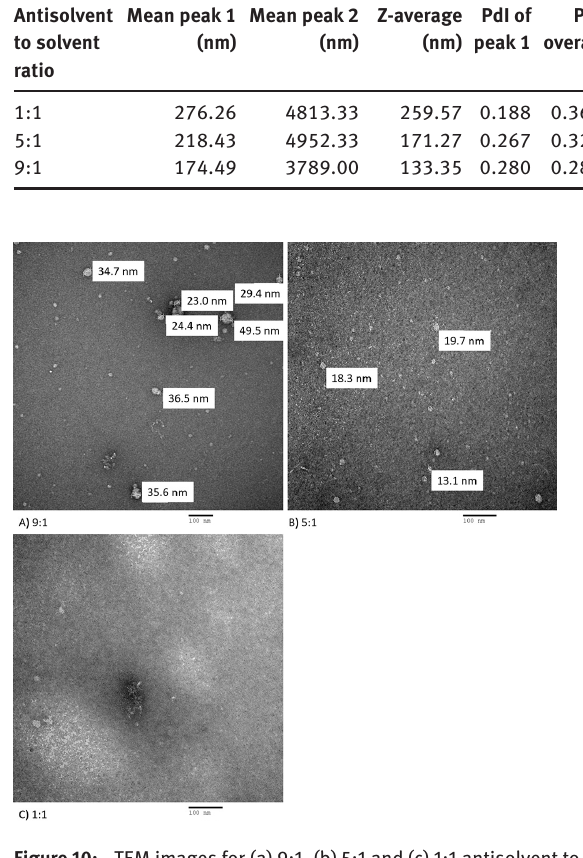
Figure 10: TEM images for (a) 9:1, (b) 5:1 and (c) 1:1 antisolvent to solventratios at 18 mL/s and 1200 rpm.